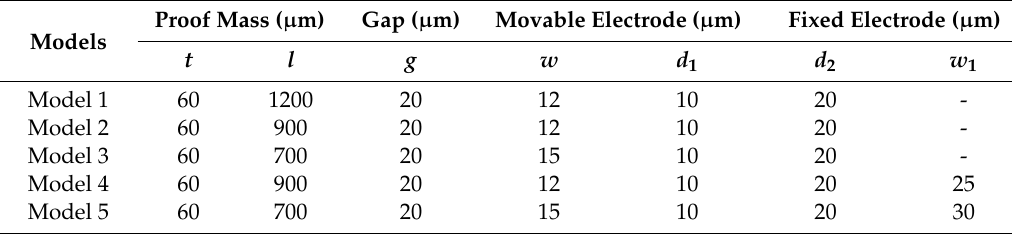
Figure 1. Design models with different thresholds. ( a ) Movable electrode with six spring coils and fixed electrode with perforated cantilever, ( b ) four spring coils, ( c ) three spring coils, ( d ) movable electrode with three spring coils and a fixed electrode constituted by springs, ( e ) top view of the location of the fixed electrode shown in (d), ( f ) additional model with the spring fixed electrode, ( g ) top view of the fixed electrode shown in (f). Table 1. Main geometric parameters of designed inertial switch.